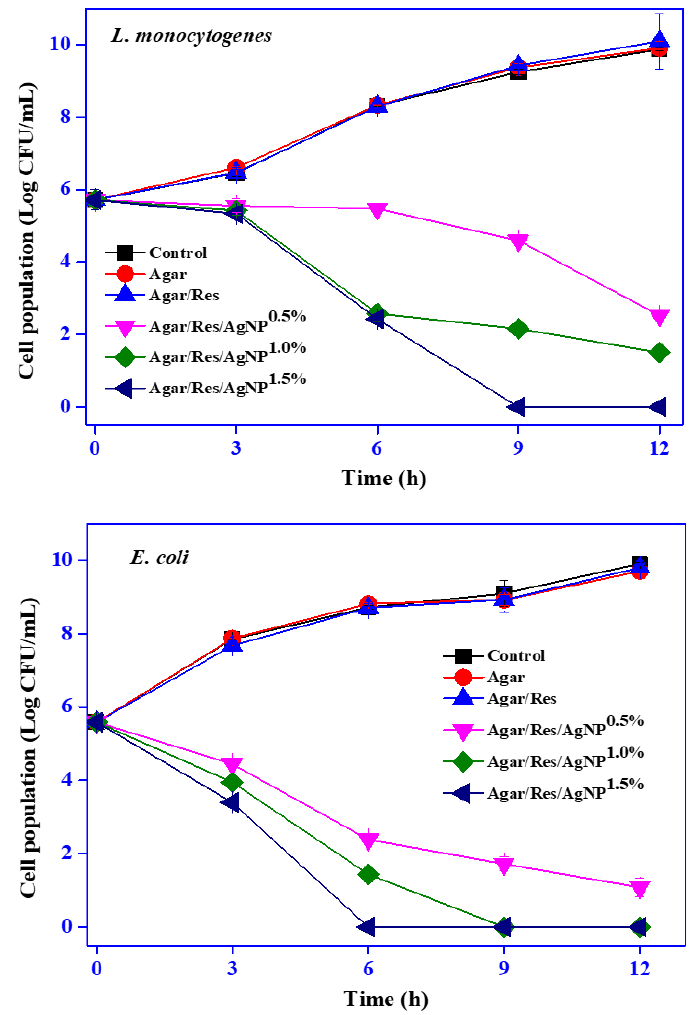
Figure 6. Antimicrobial activity of the agar-based composite films against E. coli and L. monocytogenes .